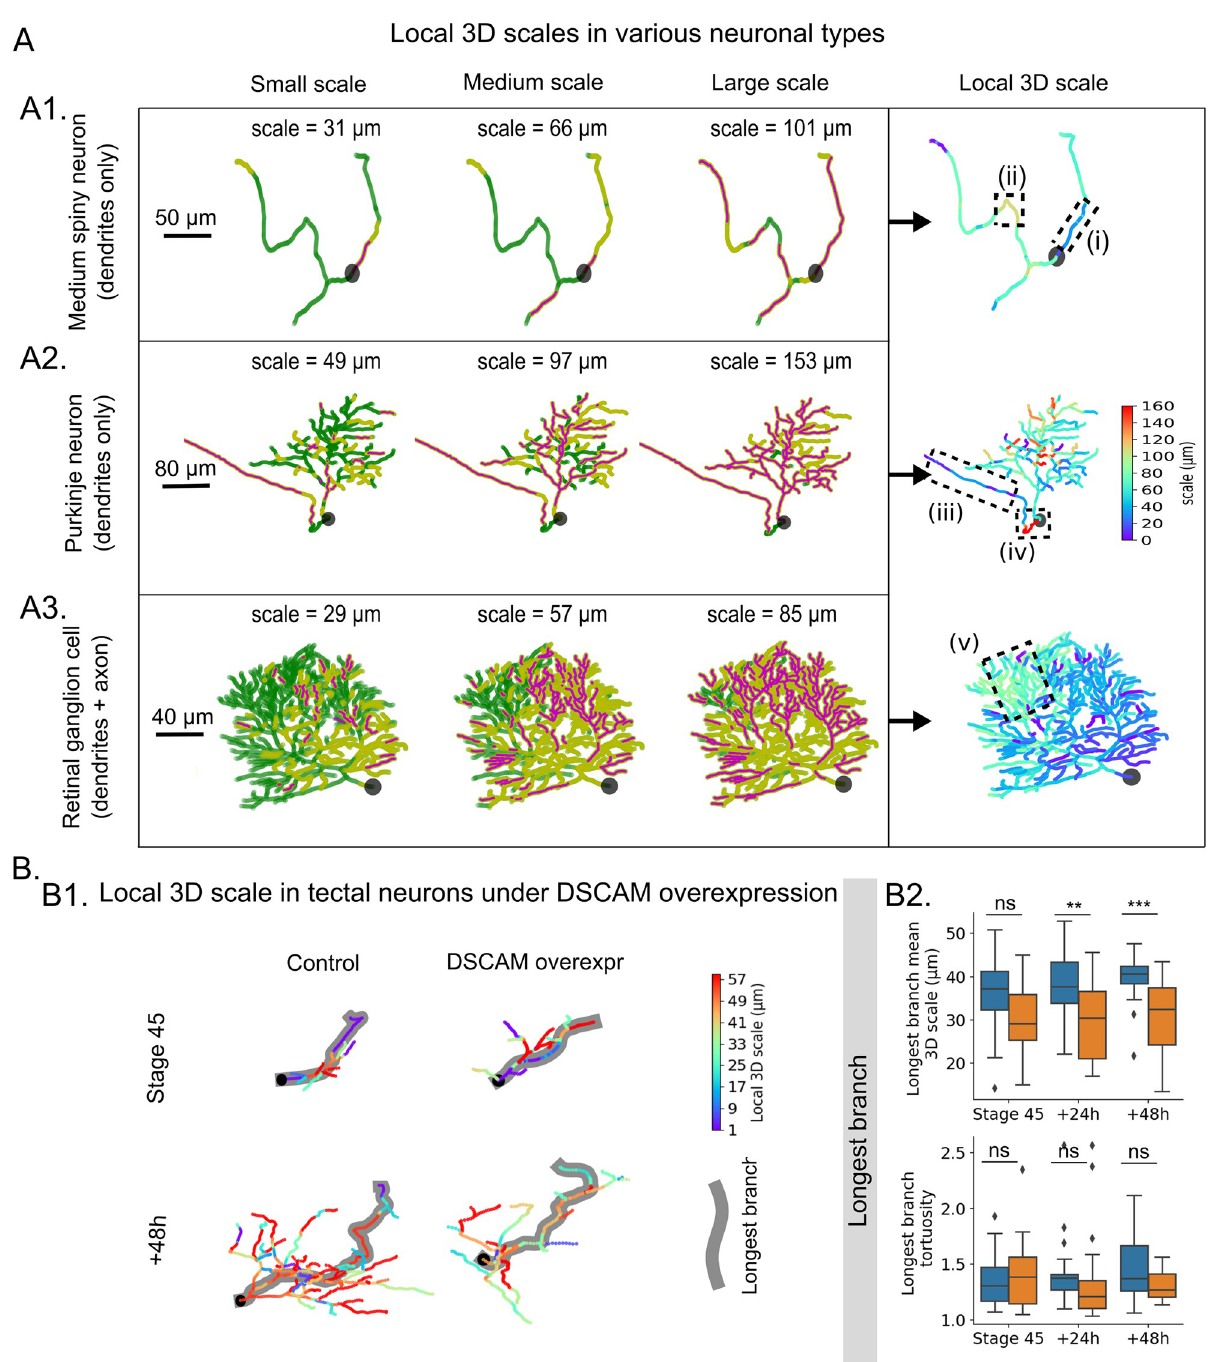
Fig 2. Local 3D scale analysis of various neuronal traces. (A) Application of nAdder to three types of mouse neurons with different arbor shape and size: (A1) striatal D2 medium spiny neuron [39], (A2) retinal ganglion cell [40], (A3) cerebellar Purkinje neuron [41]. The first three columns show the intrinsic dimensionality decompositions of the neurons at small, medium and large scales. The local 3D scale, computed from suites of such decomposition across multiple scales, is shown in the last column. The maximum scale is set at 160 μ m based on the longest branch analyzed. Dotted line boxes (i-v) frame areas of interest discussed in the text. (B) Dendritic arbor traces from X. laevis tectal neurons were obtained from [26]. (B1) Examples of local 3D scale maps from control (left) and DSCAM-overexpressing (DSCAM overexpr) neurons at Stage 45, and 48 hr after initial imaging. The maximum scale is set to 60 μ m based on the mean length of the arbor’s longest branch (highlighted in gray). The cell body’s position is indicated by a black square. (B2) Mean local 3D scale (above) and tortuosity (bellow) of the longest branch. Two-way ANOVA, Student’s t-test with Holm-Sidak for multiple comparisons were used, � p � 0.05, �� p � 0.01, ��� p � 0.005, ���� p � 0.001.